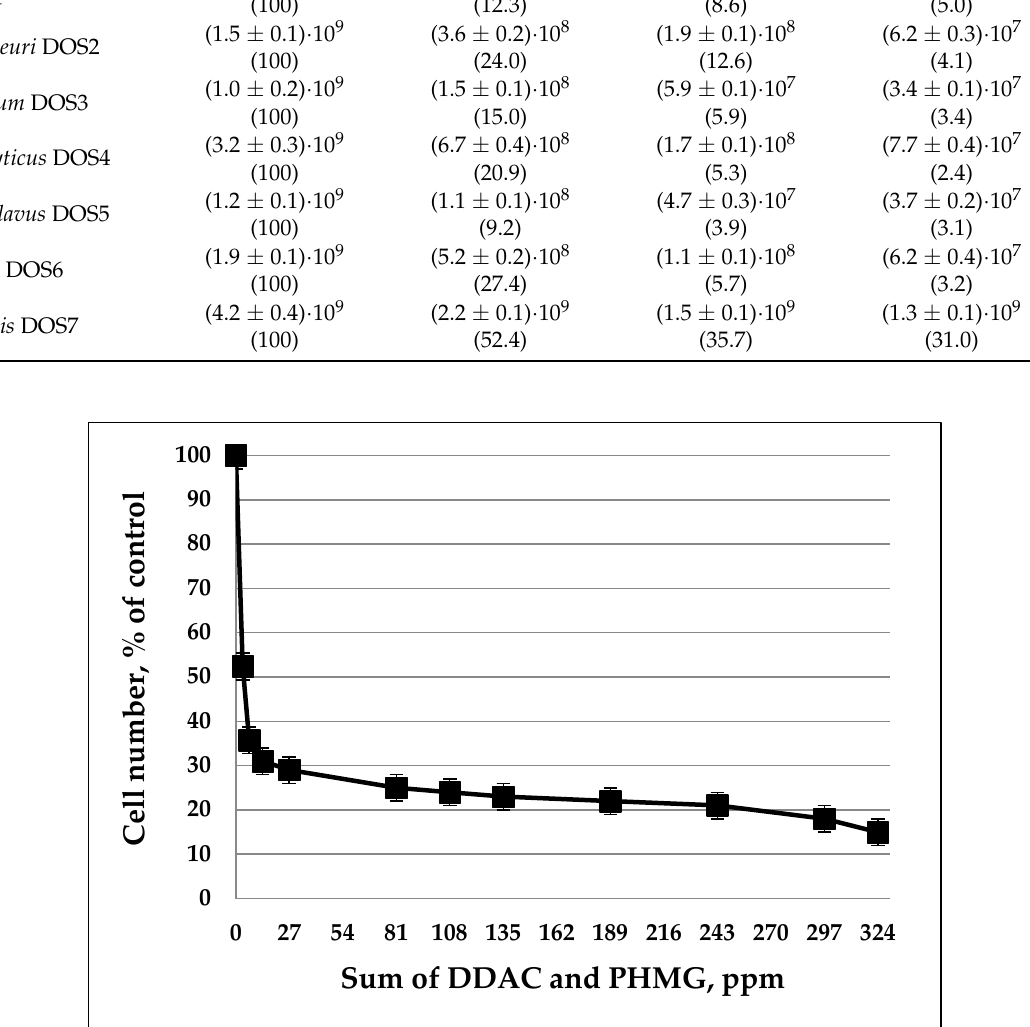
Figure 2. Effect of DDAC and PHMG on the growth of A. faecalis DOS7. In addition to the biocide “Latrina”, A. faecalis DOS7 has also shown high resistance to some individual GACs and guanidine and biguanide derivatives (Table 4). Surprisingly, MIC and MBC of “Latrina” turned out to be higher than of its individual biocidal com- ponents (DDAC and PHMG). This may be due to the presence of other surfactants in the composition of “Latrina” (in addition to PHMG and especially DDAC, which also have the ability to lower the surface tension), since it has been shown that in the presence of anionic surfactants, QACs become less effective [57]. Thus, the demonstrated resistance of the isolated bacterial cultures to the action of DDAC and PHMG provides a basis for obtaining promising biological products from